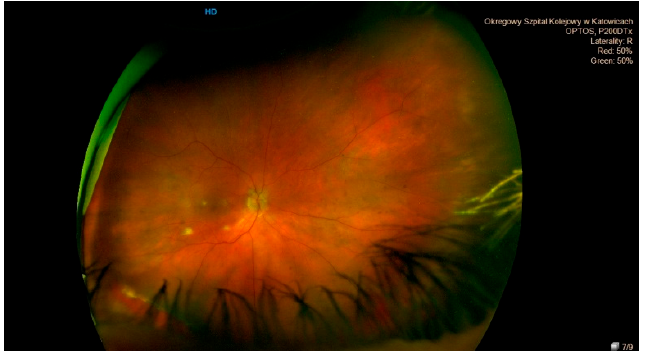
Figure 4. Black-and-white image of the fundus obtained using ultra-wide field laser scanning oph- thalmoscopy in a patient with epiretinal membrane. 2.3. Statistical Analysis Statistical analysis was performed using Statistica version 13.1 (TIBCO Software Inc., Palo Alto, CA, USA) with Pandas and Penguin statistical packages for Python. A p -value less than 0.05 was considered significant, considering multiple testing for interpretation. The normality of the variable distribution was examined using the Shapiro–Wilk test. Sta- tistical significance was calculated using a t-test for parametric variables and Mann Whit- ney U-test for non-parametric variables. For further analysis, non-parametric Spearman’s correlation coefficients were used to determine statistical dependence. 3. Results A total of 154 eyes with ERM and 122 normal (control) eyes were analyzed. If ERM was present in both eyes, only one eye of each participant was randomly selected for pos- terior segment imaging. In control patients, only one eye was randomly selected. The mean age of patients in the ERM group was 71.41 ± 8.19 (range 53–86) years and that of patients in the control group was 59.26 ± 21.21 (range 21–83) years. A total of 112 (72.72%) eyes with ERM were females and 42 (27.27%) were males. Moreover, 68 (55.73%) eyes in the control group were females and 54 (44.26%) were males. In the ERM group, 102 (66.23%) eyes were phakic and 52 (33.76%) were pseudophakic. In the control group, 96 (78.68%) eyes were phakic and 26 (21.31%) were pseudophakic. Patients with high my- opia were excluded from the initial stage of the study. The mean axial length of the eyeball in the control group was 23.43 mm, and in the ERM group, it was 23.51 mm ( p = 0.34). The mean visual acuity was 0.204 logMAR in the ERM group and 0.079 logMAR in the control group. The mean intraocular pressure was 14.31 ± 2.82 (range 11–21) mmHg in the ERM group and 14.52 ± 2.43 (range 11–19) mmHg in the control group. Goldmann three-mirror contact lens examination revealed peripheral retinal degen- eration in 96 (62.33%) eyes in the ERM group and 42 (34.42%) eyes in the control group. The results are summarized in Table 1.